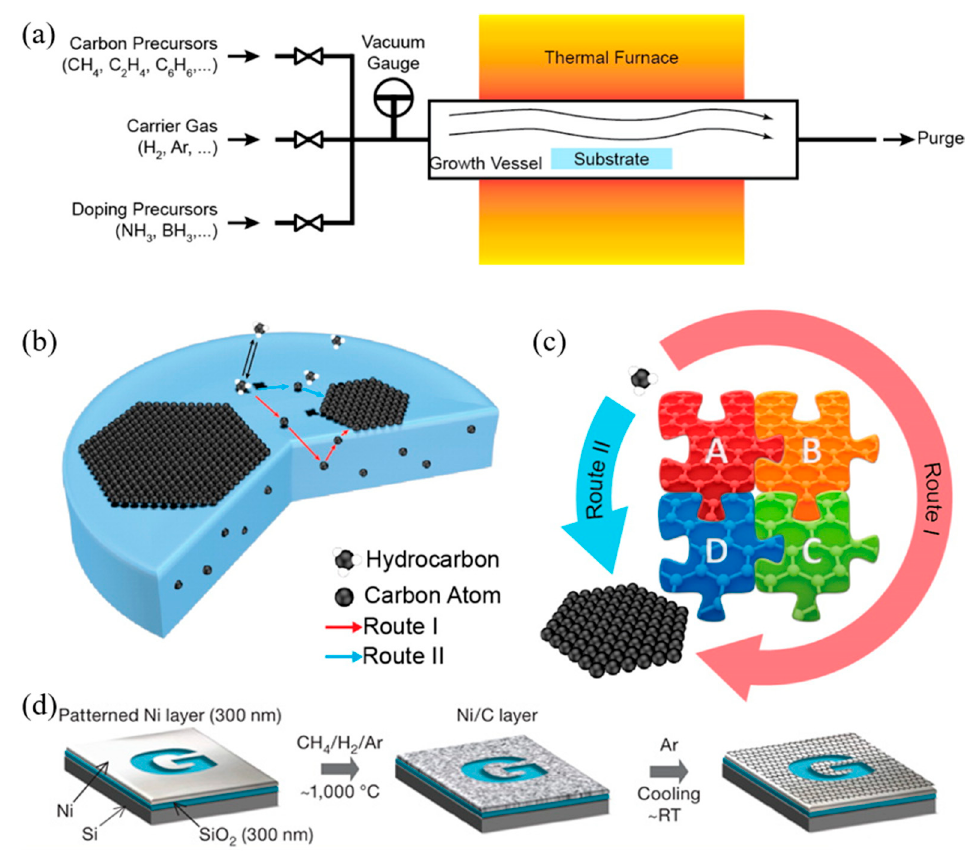
Figure 3. ( a ) Sketch drawing of typical CVD system for graphene fabrication; ( b ) elementary steps involved in CVD process (red arrow represents good metal to carbon a ffi nity, while blue arrow represents poor metal to carbon a ffi nity); ( c ) schematic illustration of four elementary steps connected together and coexistence of two routes for carbon precursors conversion to graphene [88]; ( d ) example of CVD synthesis of patterned graphene films on thin nickel films [89]. Reproduced with permission from Yan et al., Accounts of Chemical Research , published by American Chemical Society, 2013; and Kim et al., Nature , published by Nature,